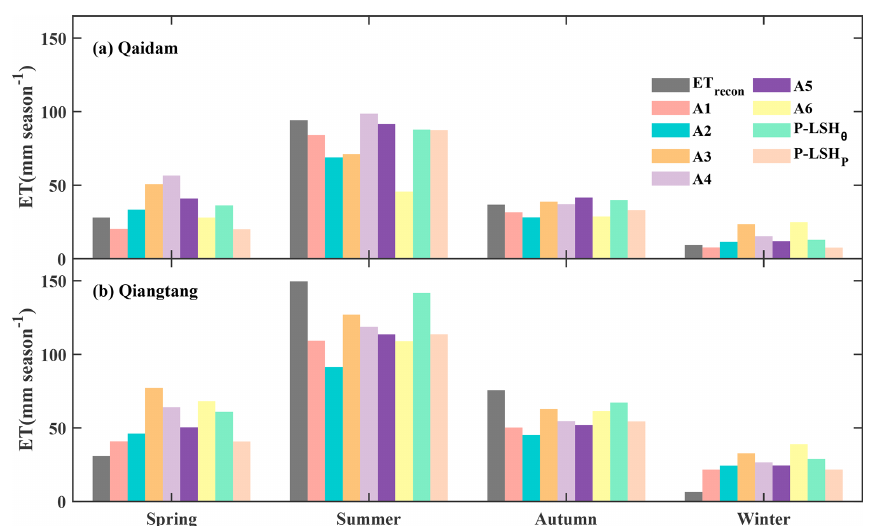
Figure 4. Seasonal average reconstructed ET (ET recon ) and ET estimates derived from six existing coupling algorithms and the two improved algorithms for (a) the Qaidam Basin and (b) the Qiangtang Plateau. The A1– A6, P-LSH θ , and P-LSH P are the coupling algorithms listed